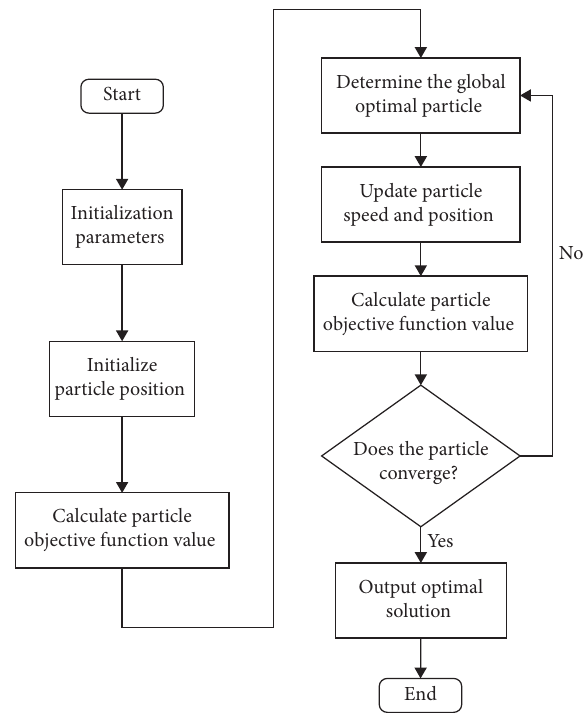
Figure 8: Flowchart of particle swarm optimization algorithm. Table 4: Simulation results of empty truck flow.